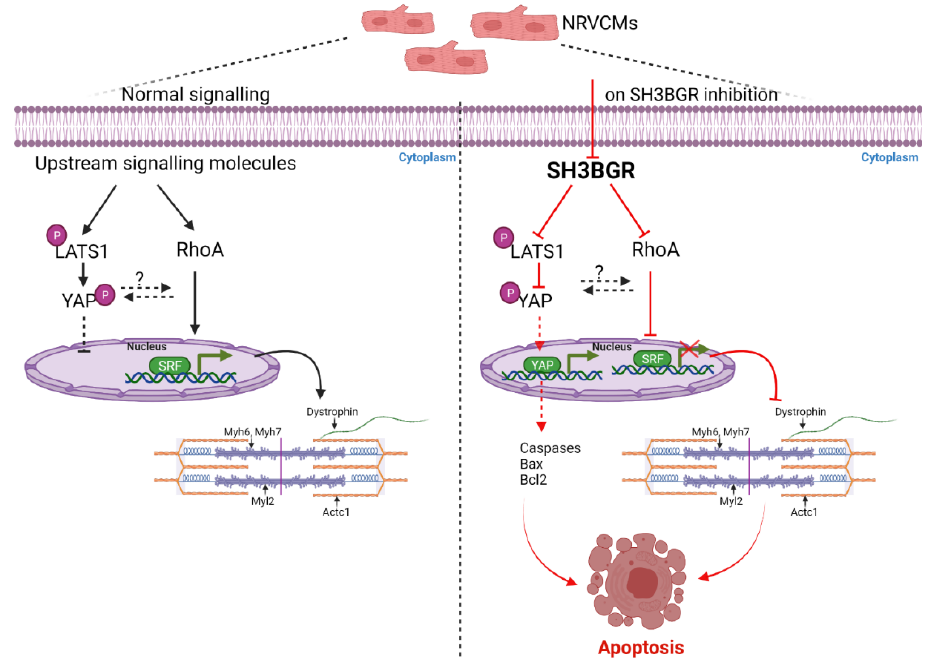
Figure 5. Mechanistic signaling- As observed in the left side panel, LATS1, when phosphorylated, is retained in the cytoplasm and also retains phosphorylated YAP in the cytoplasm, thereby resulting in no transcriptional activation of YAP. Similarly, RhoA activates SRF; the transcriptional activation of SRF is required for genes involved in sarcomere consisting of myosin heavy chain and light chain, actin, etc. On SH3BGR knockdown, as seen in right panel, phosphorylation of YAP is significantly reduced, thereby activating YAP and resulting in probable activation pro-apoptotic genes. Further, the RhoA–SRF axis is inhibited due to SH3BGR inhibition, resulting in hampered SRF activity, thereby resulting in the sarcomeric instability and leading to apoptosis of NRVCMs. SRF, Serum response factor; Myh6, myosin heavy chain 6; Myh7, myosin heavy chain 7; Myl2, Myosin light chain2; Actc1, Actin Alpha Cardiac Muscle 1; Acta1, Actin Alpha 1skeletal muscle; LATS1, Large tumor suppressor kinase 1; pLATS1, phospho Large tumor suppressor kinase 1; YAP, Yes1 Associated Transcriptional Regulator; pYAP, phospho Yes1 Associated Transcriptional Regulator; Bax, BCL2 Associated X; Apoptosis Regulator; Bcl2, B-cell lymphoma